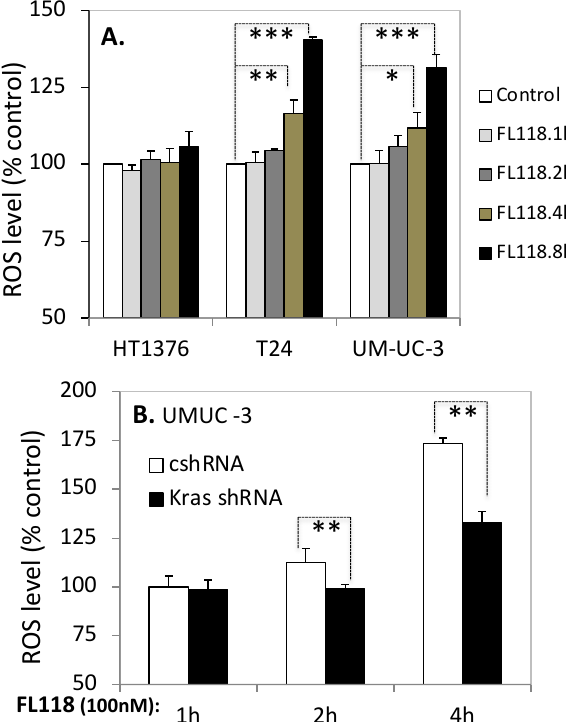
Figure 7. Determination of reactive oxygen species (ROS) production in bladder cancer cells. ( A ) FL118-induced ROS production in bladder cancer cell lines. HT1376, T24 and UMUC-3 cells in 96-well plates were treated with DMSO or 100 nM FL118 for di ff erent time points as indicated. At the end of treatment, ROS production was measured using Abcam’s 2 (cid:48) ,7 (cid:48) -dichlorofluorescin diacetate (DCFDA) cellular reactive oxygen species detection kit, as described in the Materials and